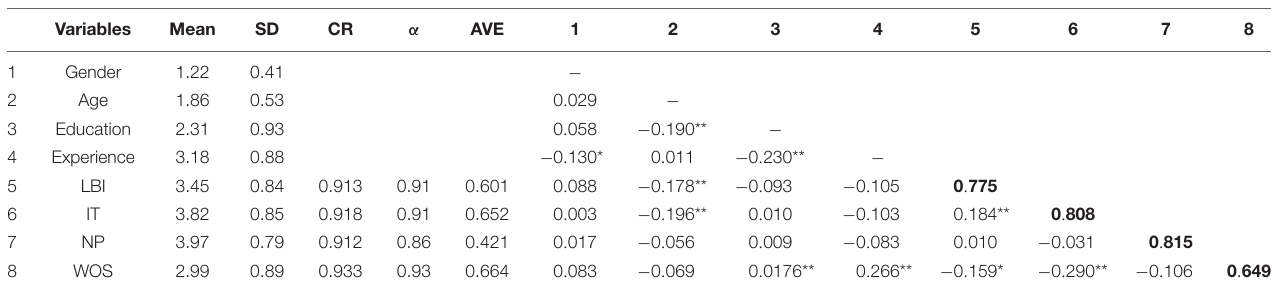
TABLE 2 | Descriptive statistics, correlation analysis, and discriminant